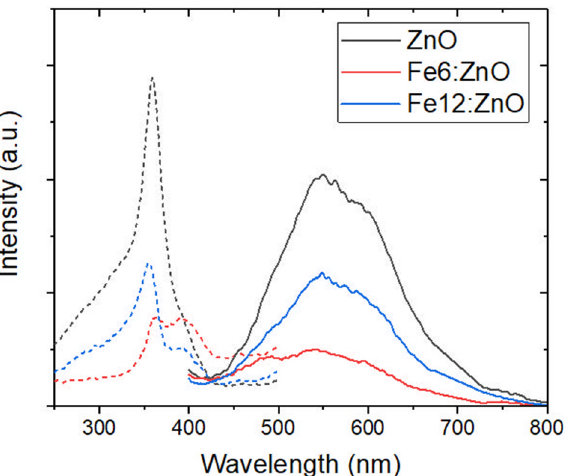
Figure 8. Fluorescence spectra of ZnO and Fe:ZnO NPs. Dashed lines represent the signal retrieved when exciting the sample at wavelength below λ = 500 nm and collecting the emission at λ = 550 nm; solid lines refer to the emission retrieved by exciting the sample at λ = 348 nm.